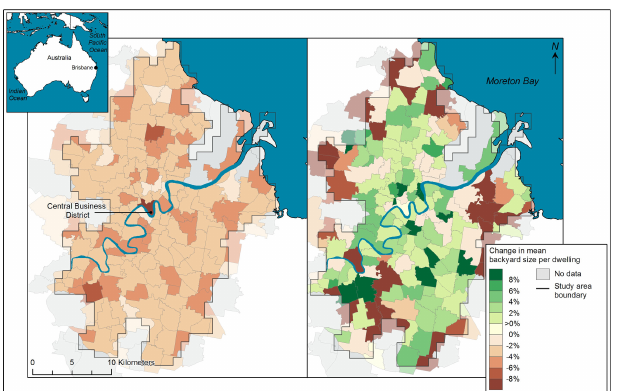
dwelling for each suburb in the study area for (a) compact and (b) sprawling urban growth scenarios. Suburbs with a mean increase or no change in backyard size are colored dark to light green while suburbs with a mean decrease in backyard size are colored light to dark red.